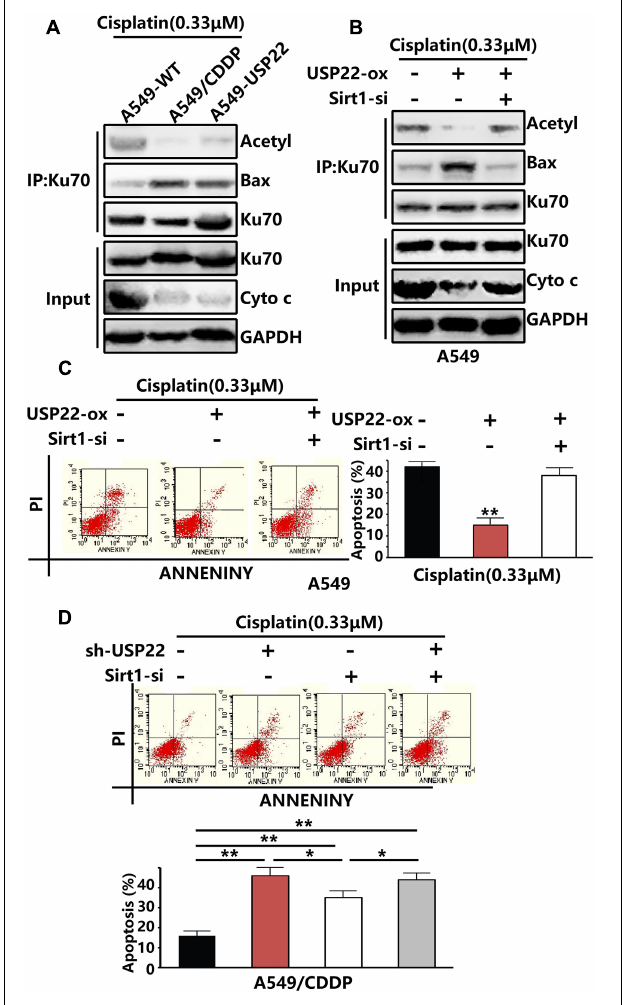
FIGURE 5 | The cisplatin sensitivity in cisplatin-resistant A549/CDDP cells was restored by USP22 inhibition. (A) The sensitivity to cisplatin of A549/CDDP and A549/CDDP-sh-USP22 (the cell clones which were stably transfected with sh-USP22) cells was detected by CCK-8. Cells were exposed to various concentrations of cisplatin for 48 h. (B) The response of A549/CDDP and A549/CDDP-sh-USP22 cells to cisplatin was tested by colony-forming assay. Cell lines were treated continuously with 0 or 0.33 µ M cisplatin for 14 days. (C) A549/CDDP and A549/CDDP-sh-USP22 cells were treated with 0.33 µ M of cisplatin for 48 h and subjected to flow cytometry analysis of cell cycle distribution. Percentage change in G1 phase is shown. (D) Cisplatin-induced apoptosis in A549/CDDP and A549/CDDP-sh-USP22 cells was demonstrated by flow cytometric analysis. Cell lines were treated continuously with 0.33 µ M of cisplatin for 48 h. (E) Every experiment was conducted at least three times, and the average is shown (mean ± SD). ∗ P < 0.05, ∗∗ P < 0.01,